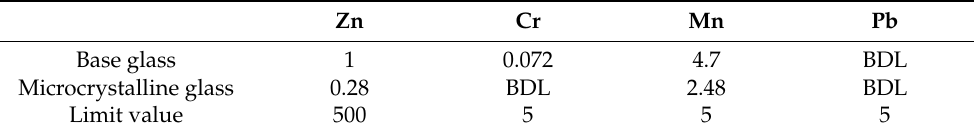
Table 3. Heavy metal leaching characteristics of the microcrystalline glass prepared under optimal conditions (mg/L). Zn Base glass Microcrystalline glass Limit